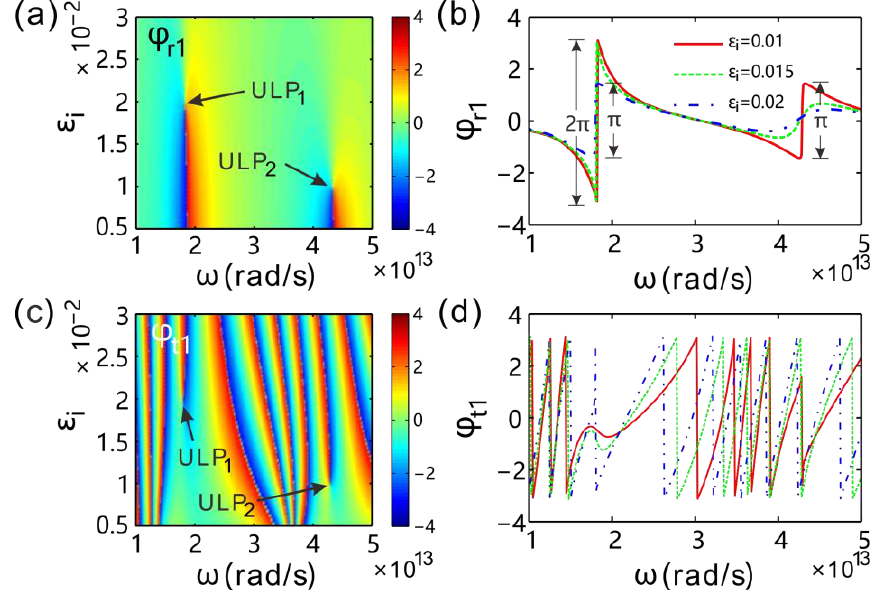
Figure 4. ( a , c ) The phases of reflection and transmission coefficient varying with the permittivity and angular frequency, respectively. ( b , d ) The phases of reflection coefficient and transmission coefficient varying with the angular frequency for three different permittivities ε i = 0.01, 0.015 and 0.02, respectively. The light was incident from the left for (a–d).